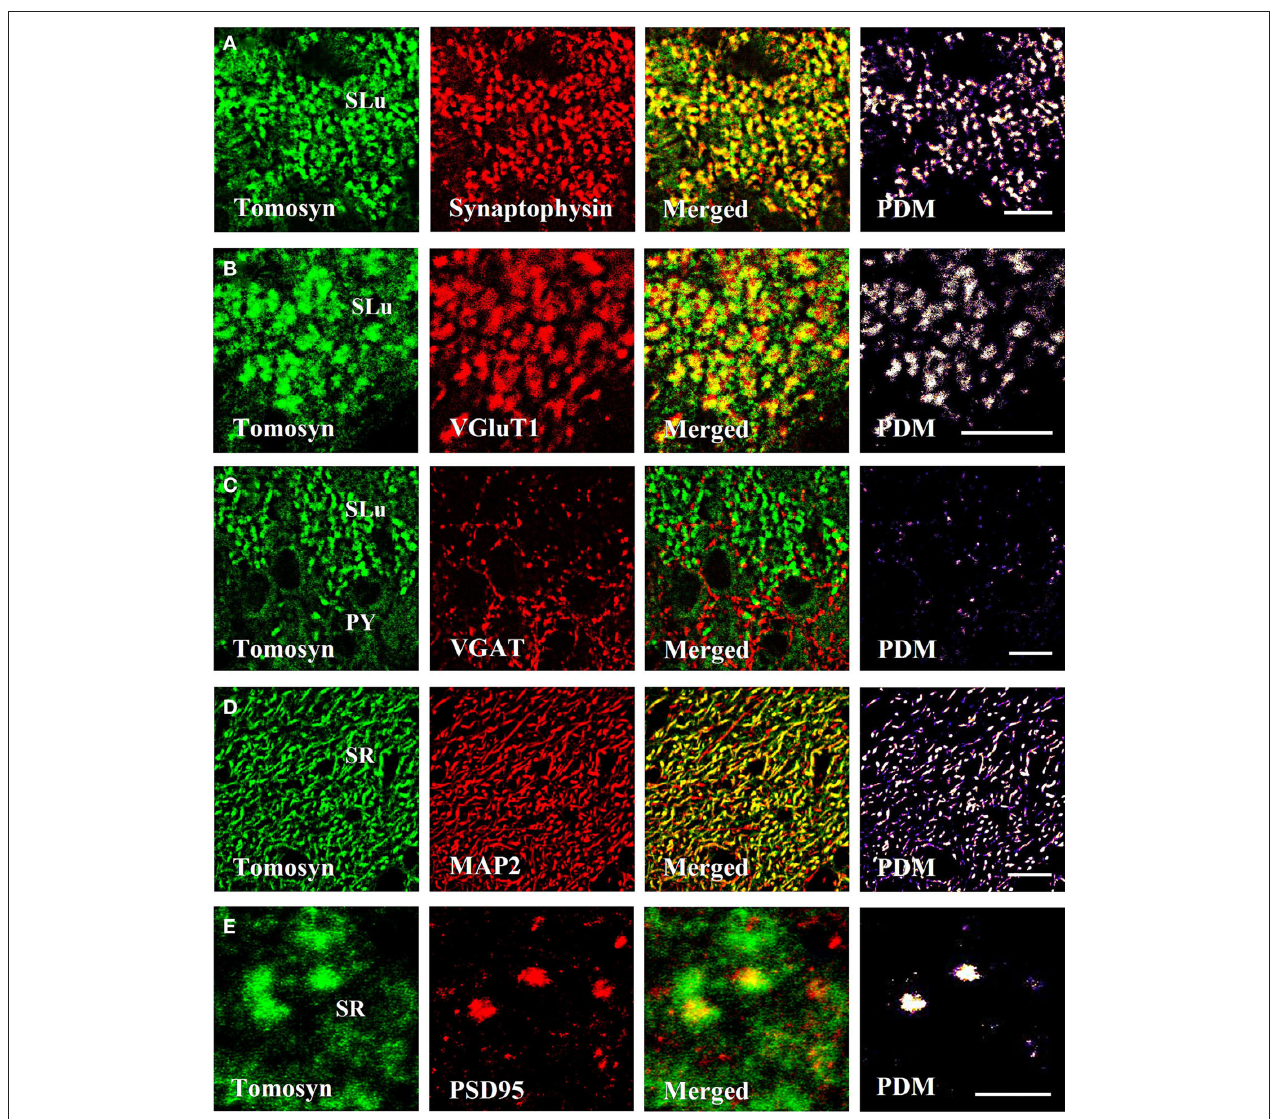
MAP2 in the stratum radiatum of CA2. (e) Tomosyn colocalization with PSD95 in the stratum radiatum of CA2. PDM, positive product of the differences from the mean; SR, stratum radiatum of CA2; SLu, stratum lucidum of the mossy fibers; IIP, intra- and infrapyramidal of the mossy fibers; Hi, hilus; PY, CA3 pyramidal cells. In positive PDM images, bright spots represent colocalization. Scale bar: (A–D) = 10 μm, (e) = 5